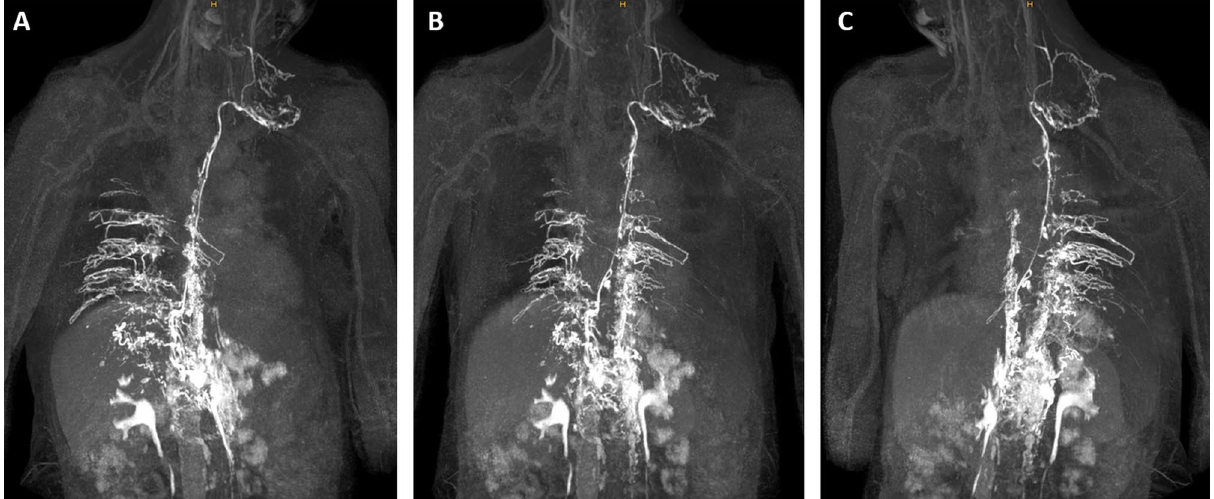
Figure 4. 50-year-old woman with peripheral/genital edema and chylocolporrhea. ( A ) Right-anterior oblique, ( B ) anterior–posterior, ( C ) left-anterior oblique MIP reconstructions of contrast-enhanced MR-lymphangiograms demonstrating a thin, but continuous thoracic duct with termination in the left venous junction. There is bilateral lymphatic reflux into intercostal lymphatics.